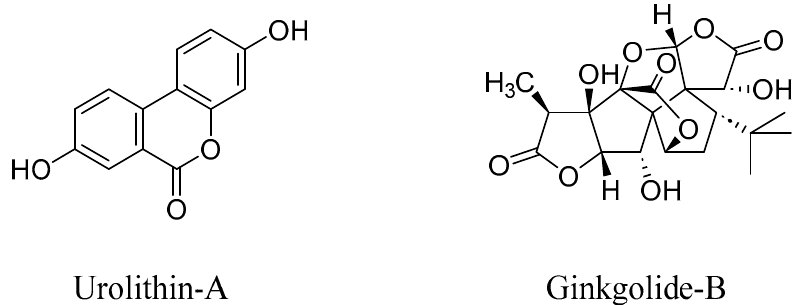
Figure 4. Structures of Urolithin-A, a microbiota-derived metabolite of ellaginic acid, and Ginkgolide-B, a constituent of the Ginkgo biloba leaves.